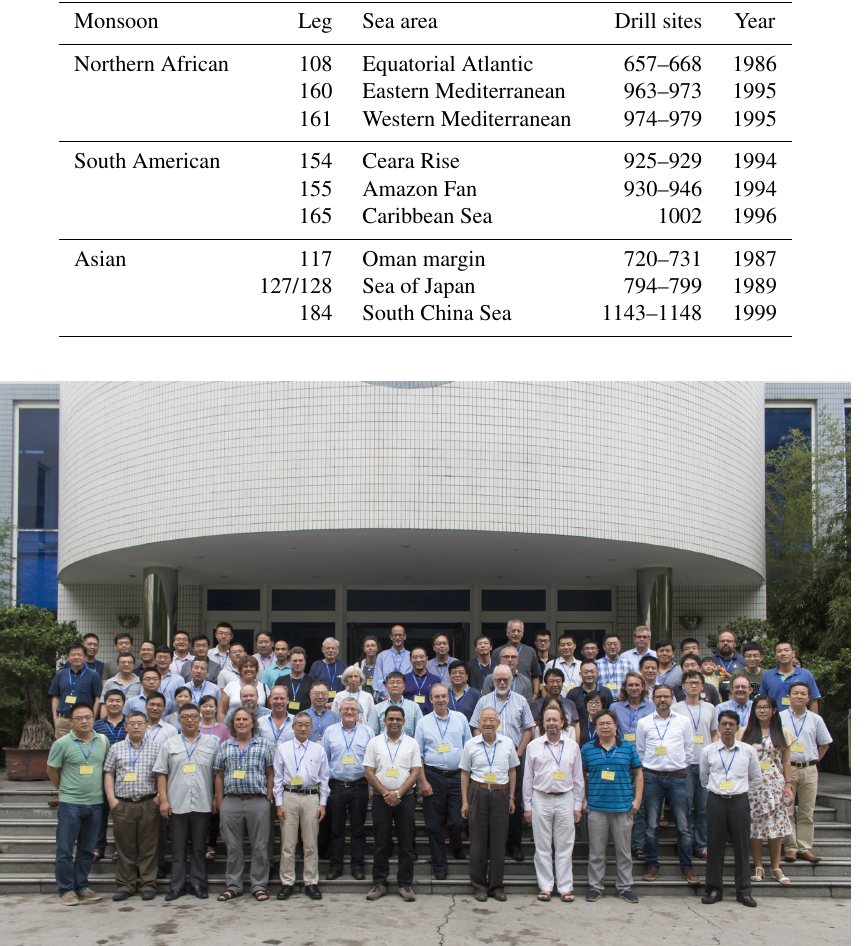
Figure 2. Participants of the IODP-PAGES Global Monsoon